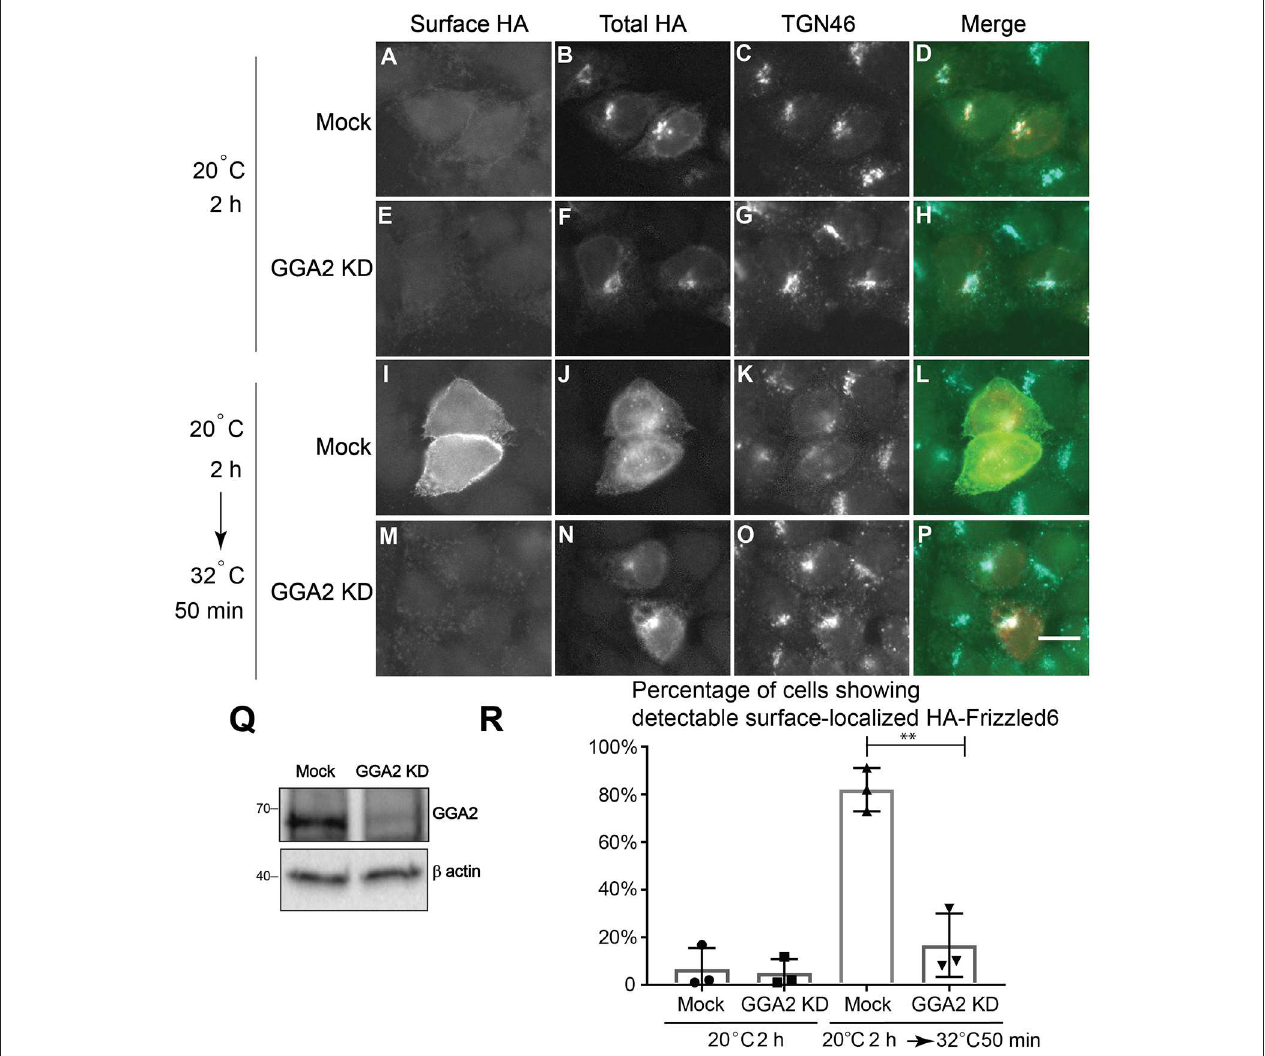
FIGURE 4 | GGA2 regulates TGN export of Frizzled6. (A–P) HeLa cells were mock transfected (A–D,I–L) or transfected with siRNA against GGA2 (E–H,M–P) and re-transfected after 48h with plasmids encoding HA-Frizzled6 (A–P) . On day 3 after knockdown, cells were incubated at 20 ◦ C for 2h (A–H) or incubated at 20 ◦ C for 2h then shifted to 32 ◦ C for 50min (I–P) in the presence of cycloheximide. After incubation, cells were analyzed by immunofluorescence. The surface-localized HA-Frizzled6 and the total HA-Frizzled6 were stained by mouse and rabbit anti-HA antibodies, respectively. Scale bar, 10 µ m. (Q) HeLa cells were mock transfected or transfected with siRNA against GGA2. On day 3 after transfection, cells were analyzed by immunoblot. (R) Quantification of the percentage of cells showing detectable surface localized Frizzled6 in cells treated with control siRNA or siRNA against GGA2 after incubation at 32 ◦ C (mean ± SD; N = 3; > 100 cells counted for each experiment). ** p < 0.01 by two-tailed Student’s t -test.